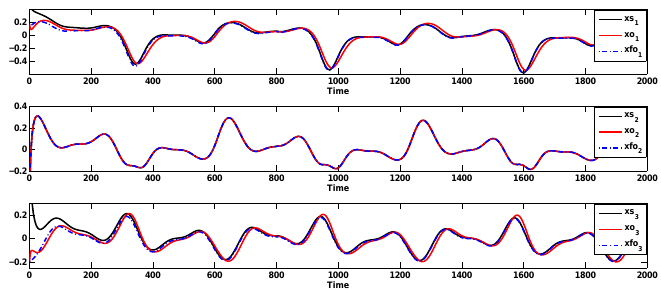
Figure 7. State estimation for the FOTS system and its estimations by FUIO and FOUIO in a faulty case.